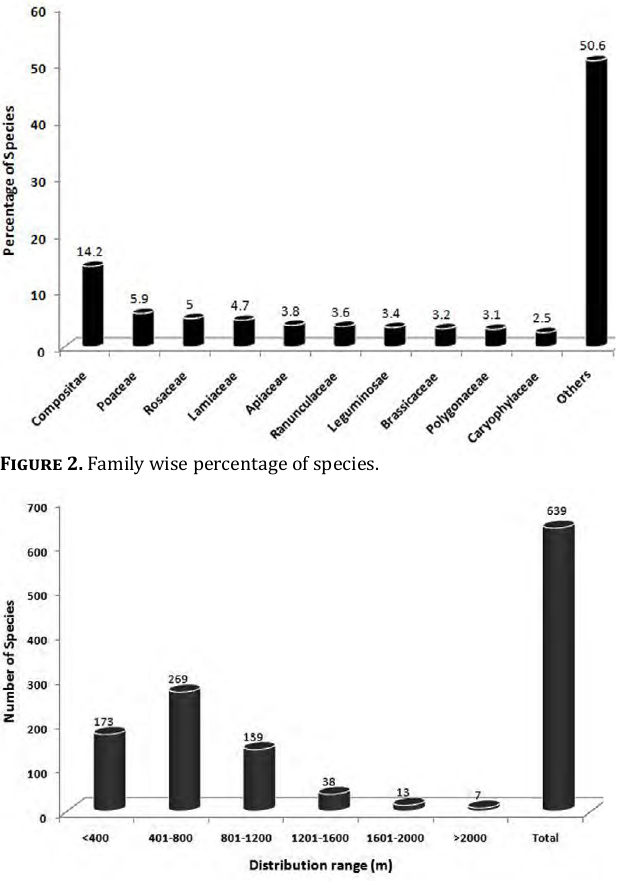
Figure 3. Altitudinal distribution range of species.